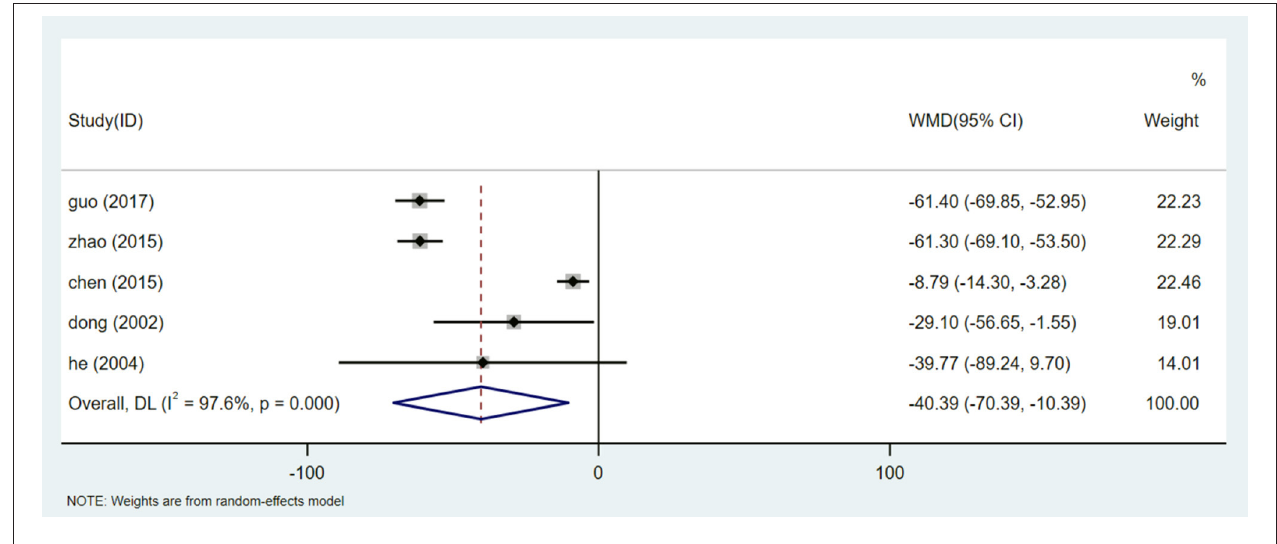
FIGURE 7 | Forest plot of Scr.